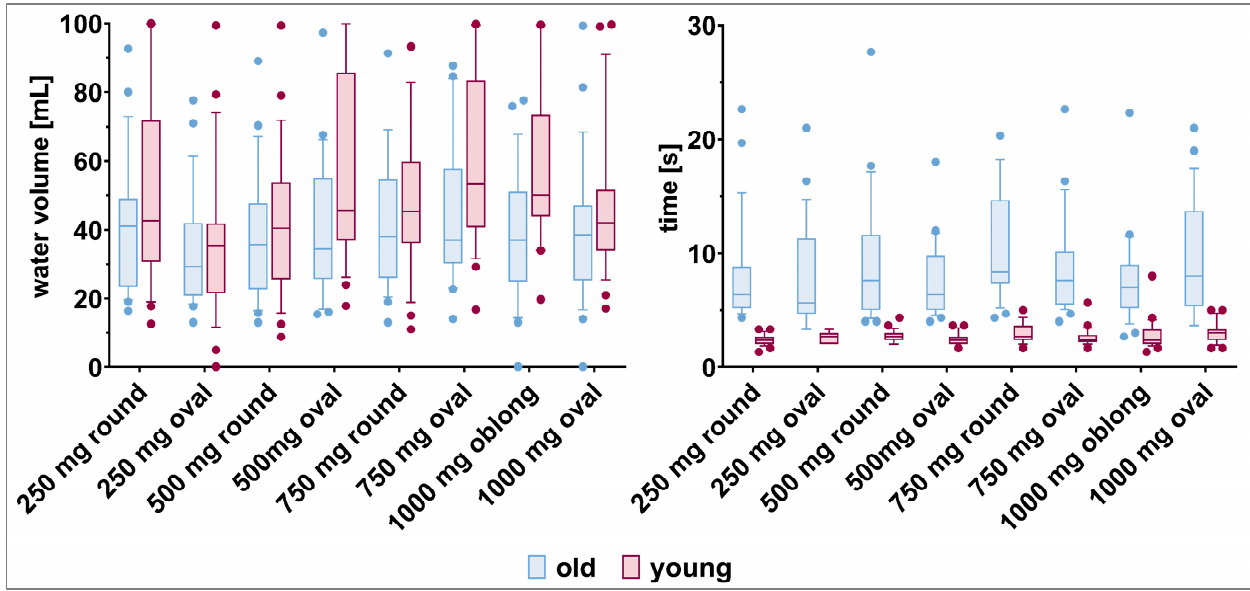
Figure 8. Water volume (left panel) and time (right panel) needed by old and young participants to swallow the tablets (mean, 10th, 90th percentile, and outliers are shown).